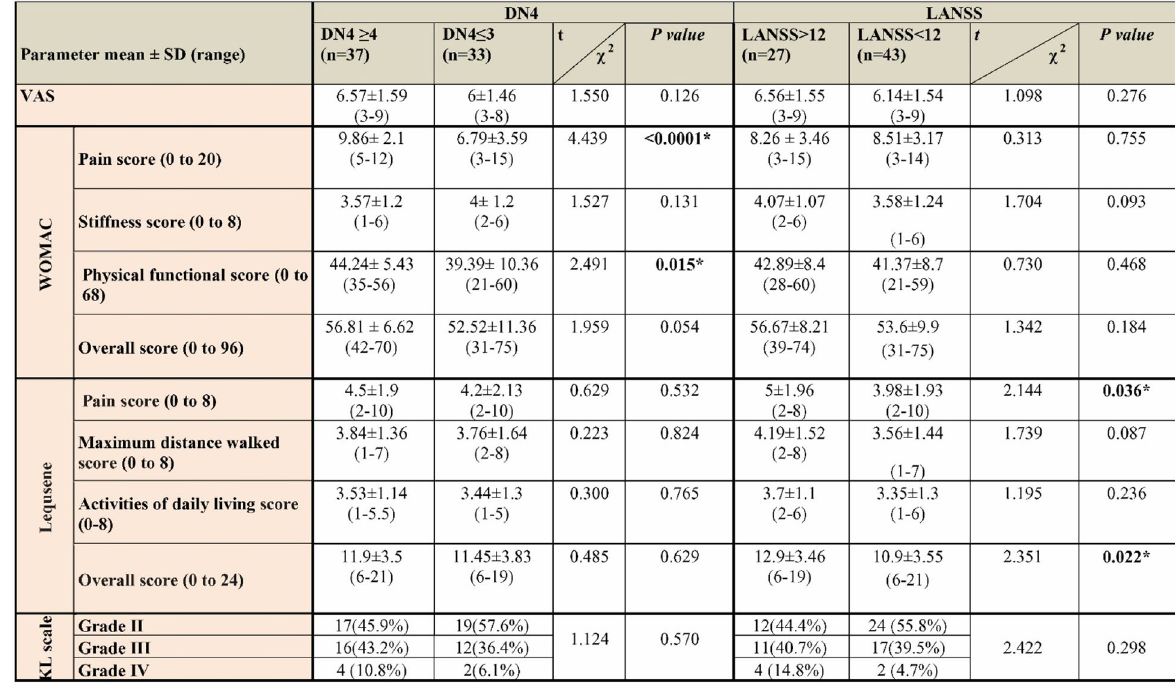
OA patients ( n =70) Patients with neuropathic Patients with non-neuropathic pain ( n =27) pain ( n =43)